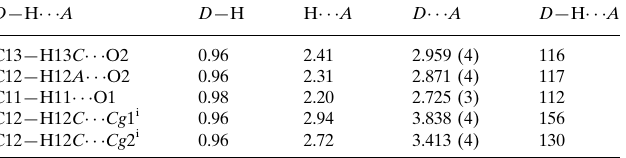
Data collection Bruker SMART CCD area-detector diffractometer Absorption correction: multi-scan ( SADABS ; Sheldrick, 1996)